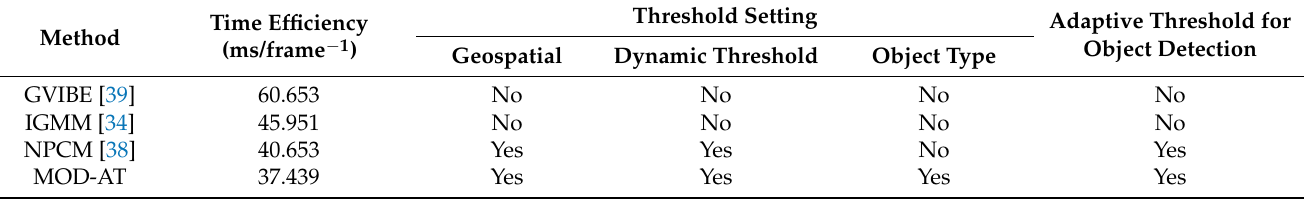
Table 6. Comparison of MOD-AT efficiency and